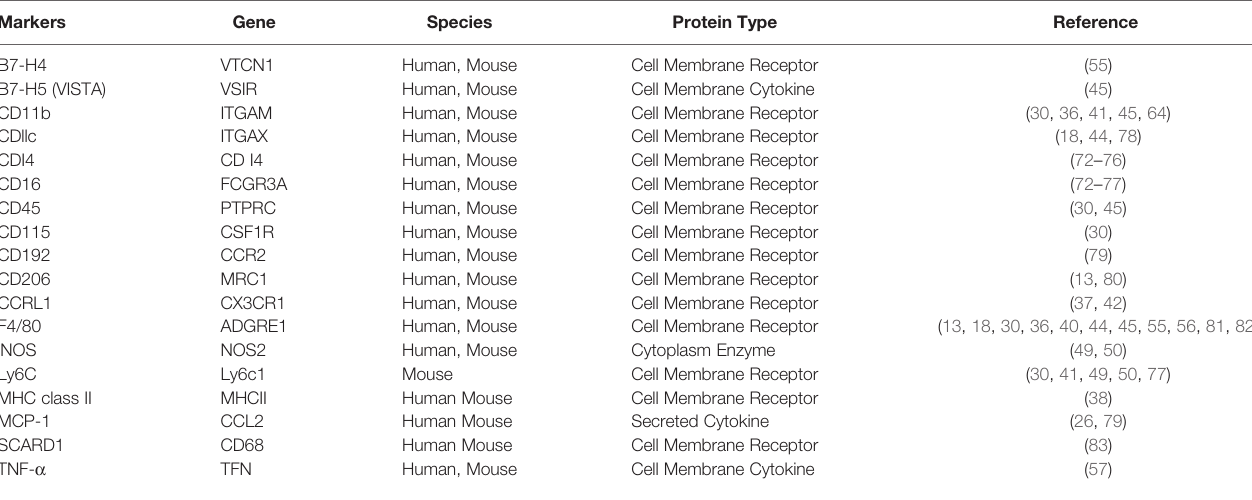
TABLE 1 | Macrophage markers in human and